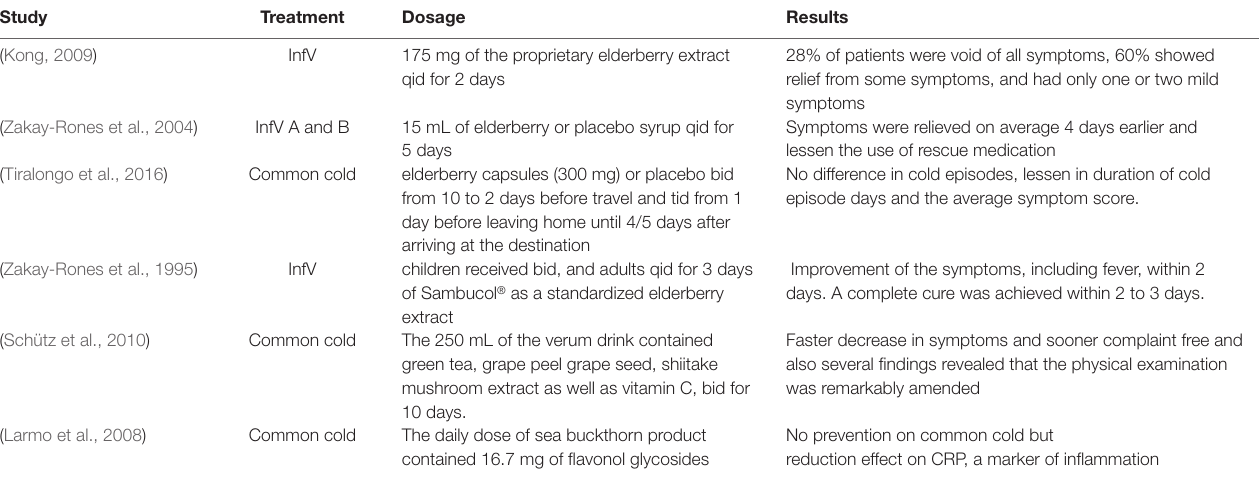
TABLE 3 | Human clinical trial investigations on the effects of some plant containing anthocyanins in the treatments of viral infections.